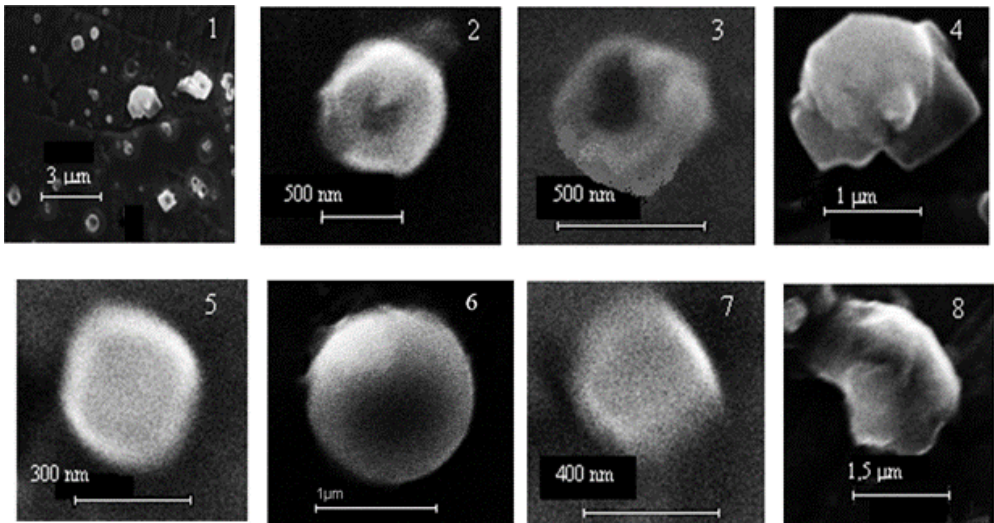
Figure 13. (1) Panorama and representative micrographs of natural background aerosols at HMO Tiksi; (2) reacted sea salt NaCl in Group Na-rich; (3) reacted sylvite KCl and (4) sylvinite (nNaCl + mKCl) in Group K-rich; (5) an organic particle in Group Organic; (6) Fe and Ca aluminosilicate in Groups Al and Si-rich; (7) Fe / Ni particle in Group Fe-rich and (8) CaCO 3 in Group Ca-rich of natural aerosols on 27 September 2014. New unpublished results of the Popovicheva et al. (2019)